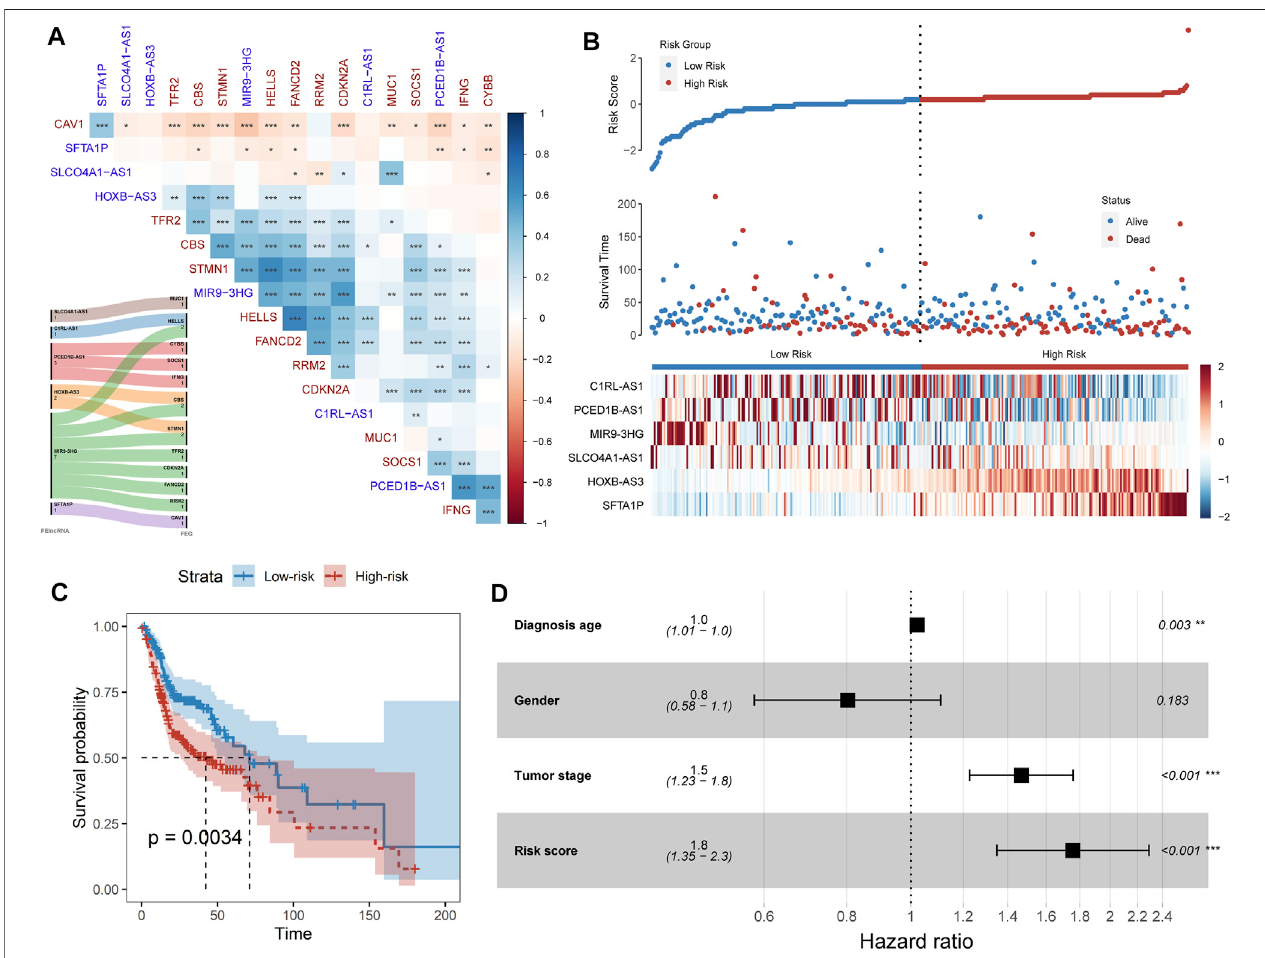
FIGURE 2 | FElncRNAs indicated the prognosis values in HNSCC. (A) Heatmap showing the Spearman ’ s correlation between FElncRNAs and FEGs. (B) Risk score distribution, survival status, and lncRNA expression patterns for patients in high- and low-risk groups by the PFLS. (C) Kaplan – Meier curve of HNSCC cancer samples strati fi ed by the risk group with the log-rank test p -value provided. (D) Forest plot showing the result of multivariate Cox regression analysis for correlation between the PFLS and clinical features and the overall survival in the TCGA